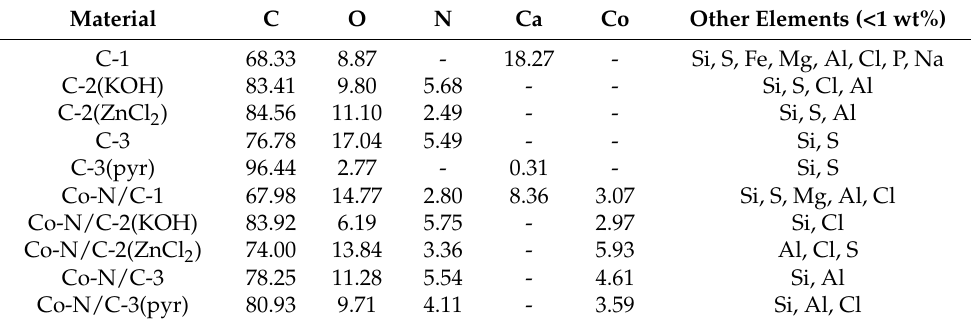
Table 1. Elemental composition (wt%) of studied materials measured by SEM-EDX.